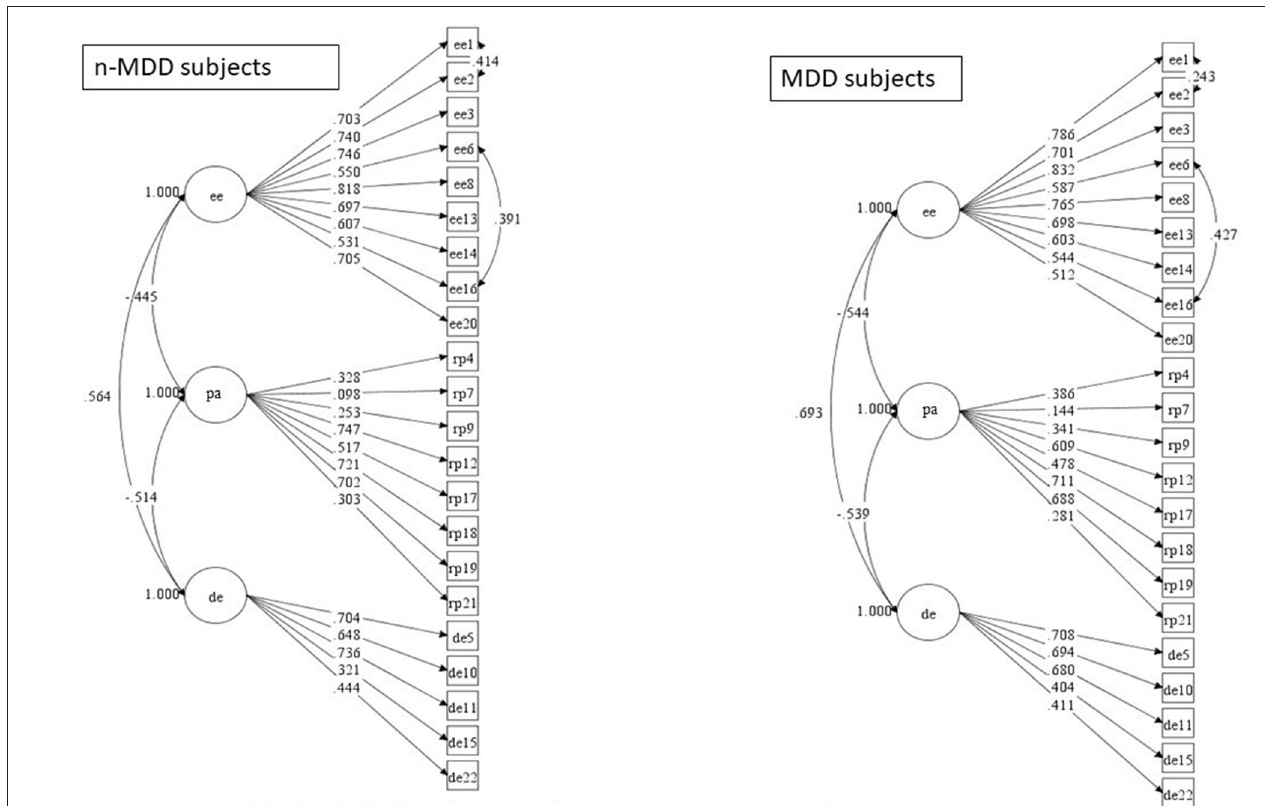
FIGURE 1 | 3-factor model of MBI-HSS in MDD and non-MDD subjects including the significant estimate values. MDD, major depressive disorder; EE, emotional exhaustion; PA, personal accomplishment; DE, depersonalization; Non-MDD subset, N = 377; MDD subset, N = 136.